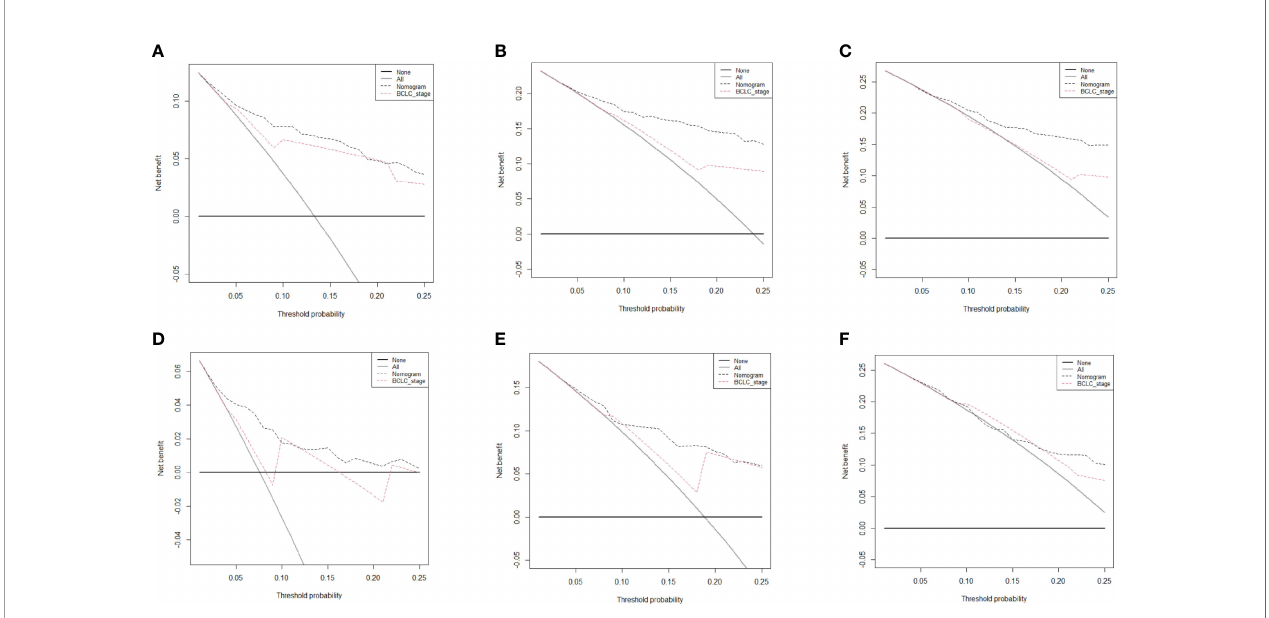
FIGURE 2 | Decision curve analysis of the nomogram and Barcelona Clinic Liver Cancer system for survival prediction in hepatocellular carcinoma (HCC) patients. The 1-, 3-, and 5-year survival in the training cohort ( A – C , respectively) and testing cohort ( D – F , respectively) in HCC patients who underwent